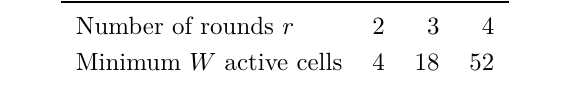
Table 4: Minimum weight for trails that remain in the kernel until the last round.